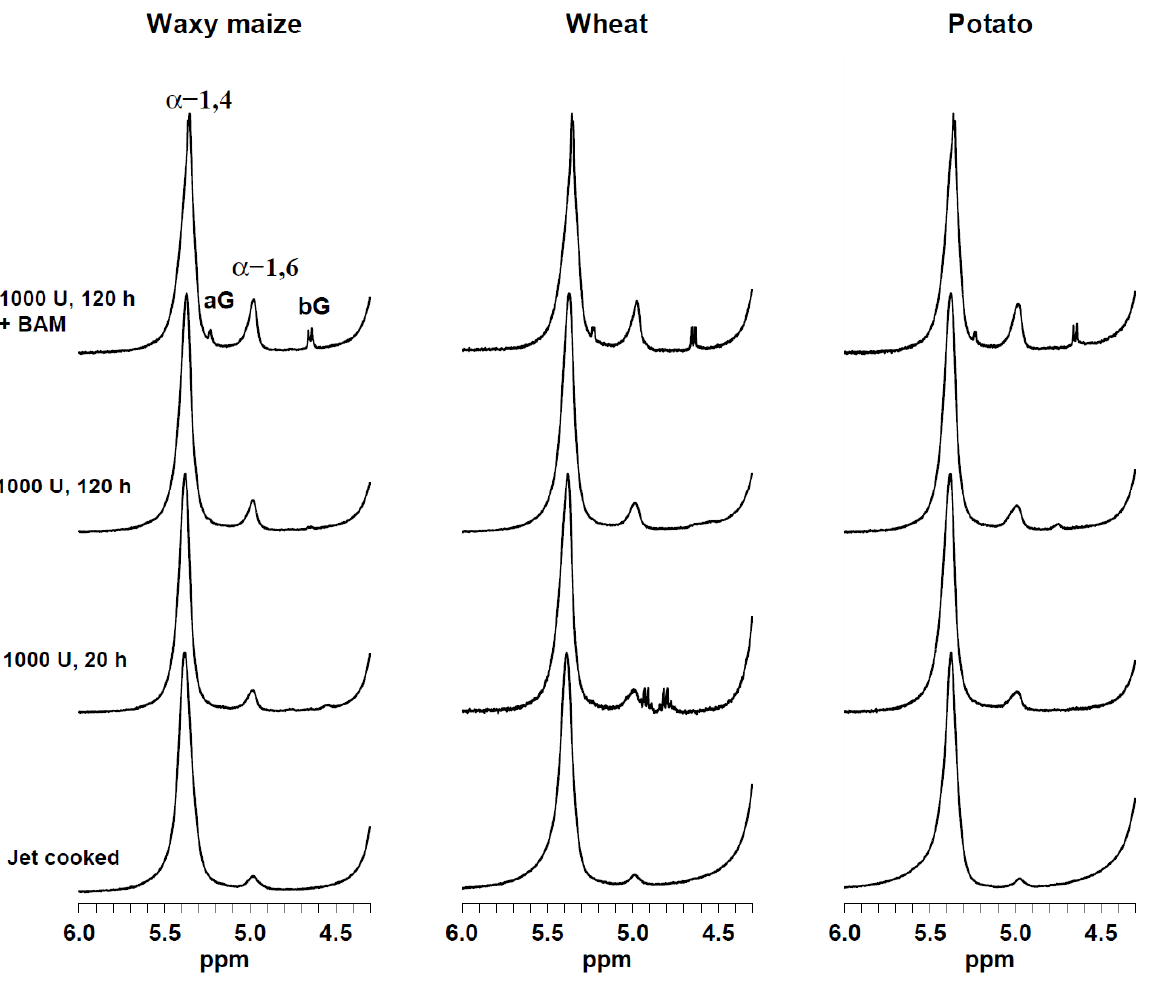
Figure 1. 1 H HR-MAS NMR spectra of starch gels at 85 °C. Resonances of anomeric hydrogens in α -(1-4) and α -(1-6) glucose linkages in polysaccharides as well as α -glucose (aG) and β -glucose (bG) monomer or end-group units are